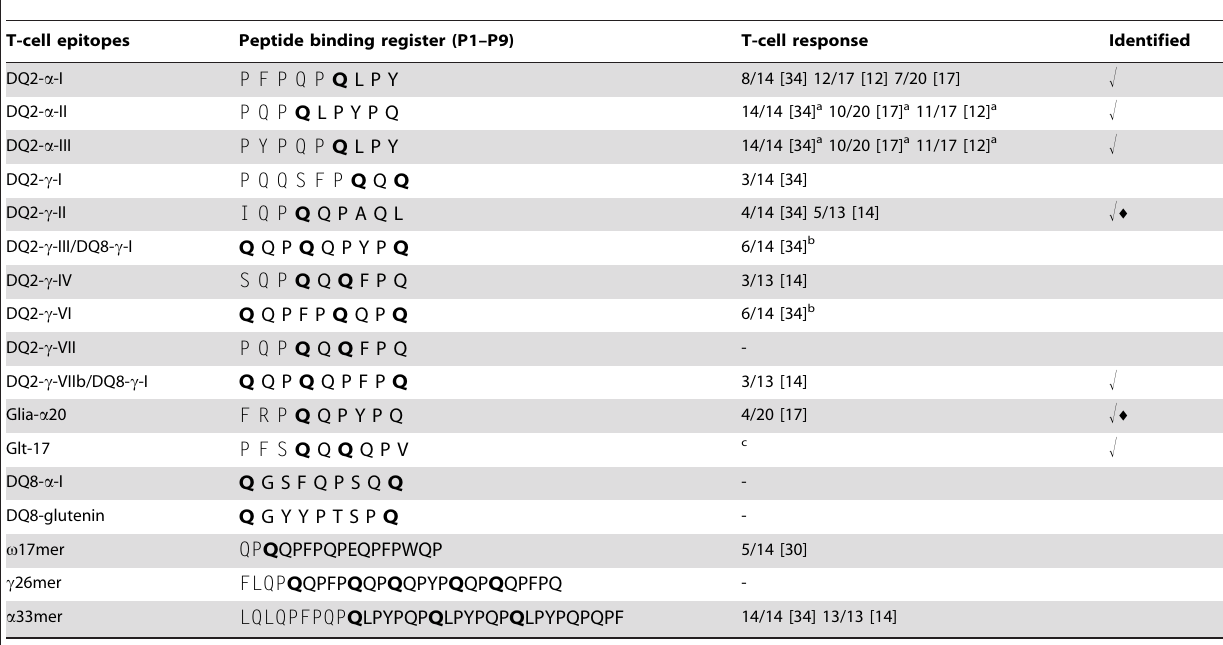
Table 1. Identified T-cell epitopes in wheat gluten and their observed T-cell response in celiac disease patients.